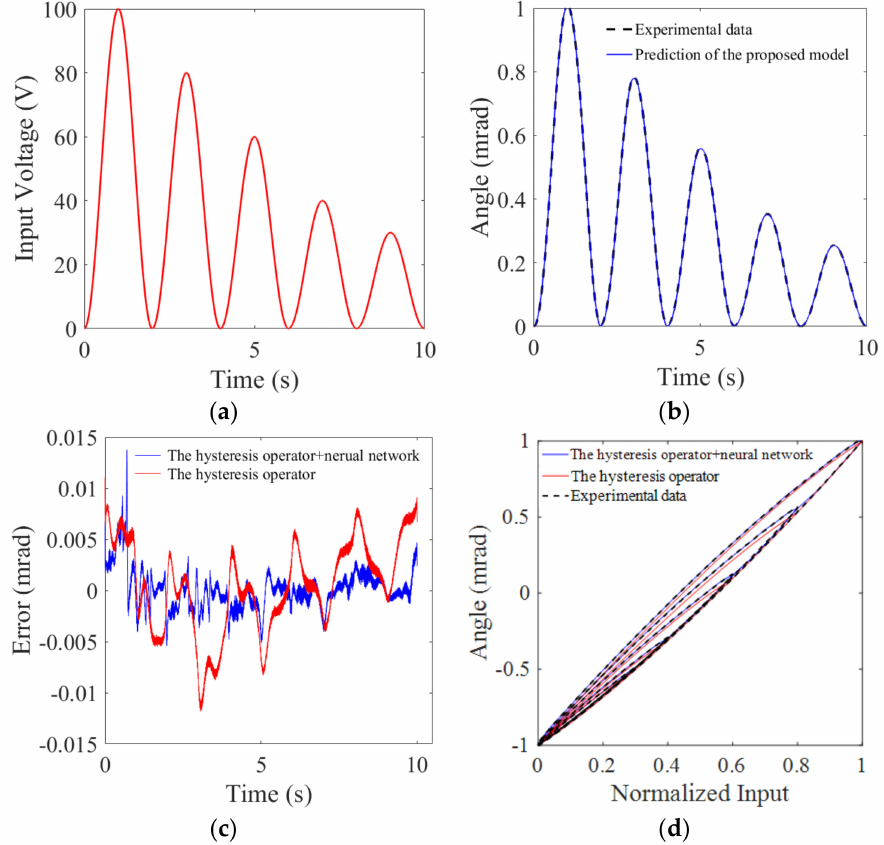
Figure 13. Experimental verification. ( a ) Input signal. ( b ) Actual and predicative angle signals. ( c ) Error. ( d ) Hysteresis